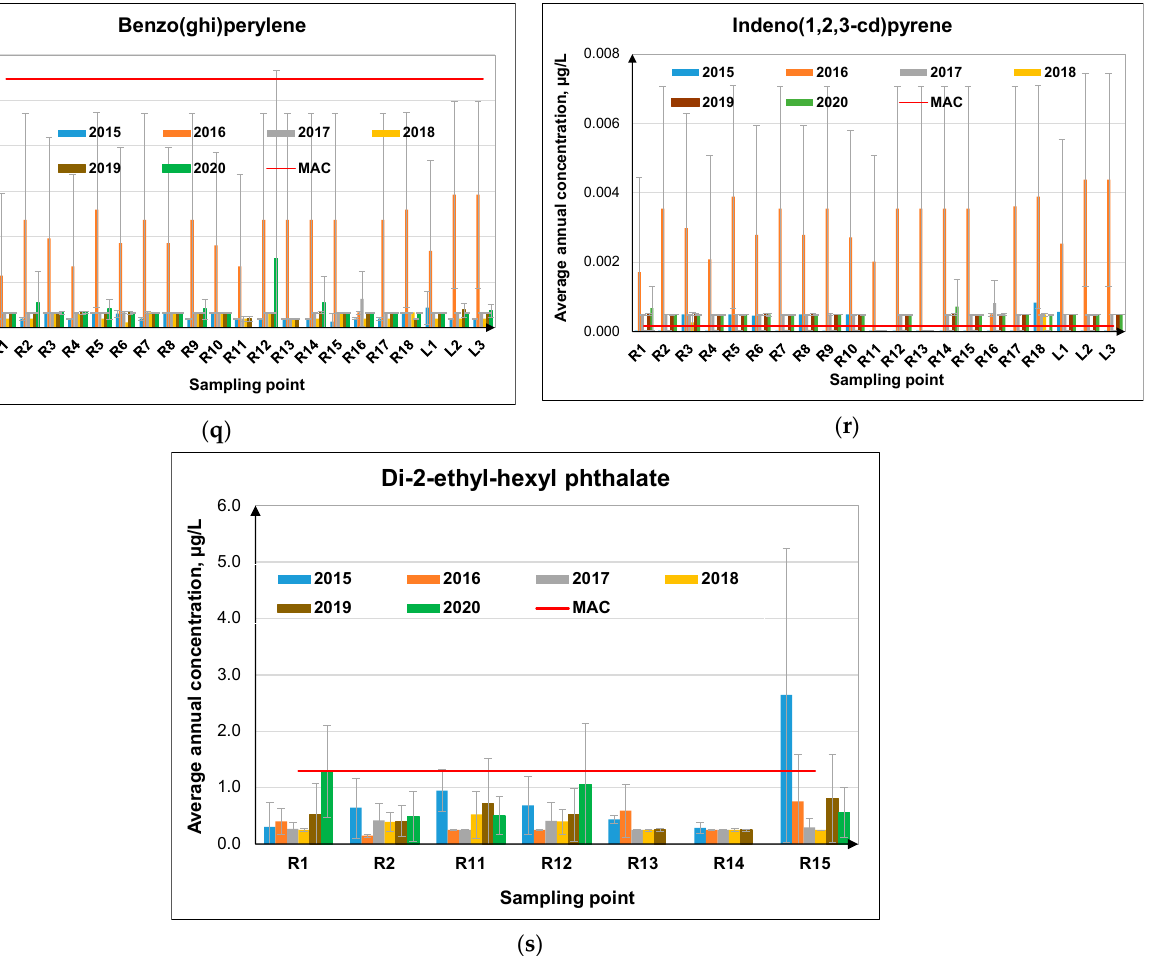
Figure 2. Monitoring results during 2015–2020 in the river sampling points (R1-R18) and lake sam- Figure pling points (L1-L3): ( a ) Arsenic; ( b ) Cadmium; ( c ) Mercury; ( d ) Nickel; ( e ) Lead; ( f ) α —Hexachlo- rocyclohexane; ( g ) β —Hexachlorocyclohexane; ( h ) γ —Hexachlorocyclohexane; ( i ) Naphthalene; ( j ) Anthracene; ( k ) Phenanthrene; ( l ) Fluoranthene; ( m ) Benzo(a)anthracene; ( n ) Benzo(b)fluoranthene; ( o ) Benzo(k)fluoranthene; ( p ) Benzo(a)pyrene; ( q ) Benzo(ghi)perylene; ( r ) Indeno(1,2,3-cd)pyrene; ( s ) Di-2-ethyl-hexyl-phthalate.